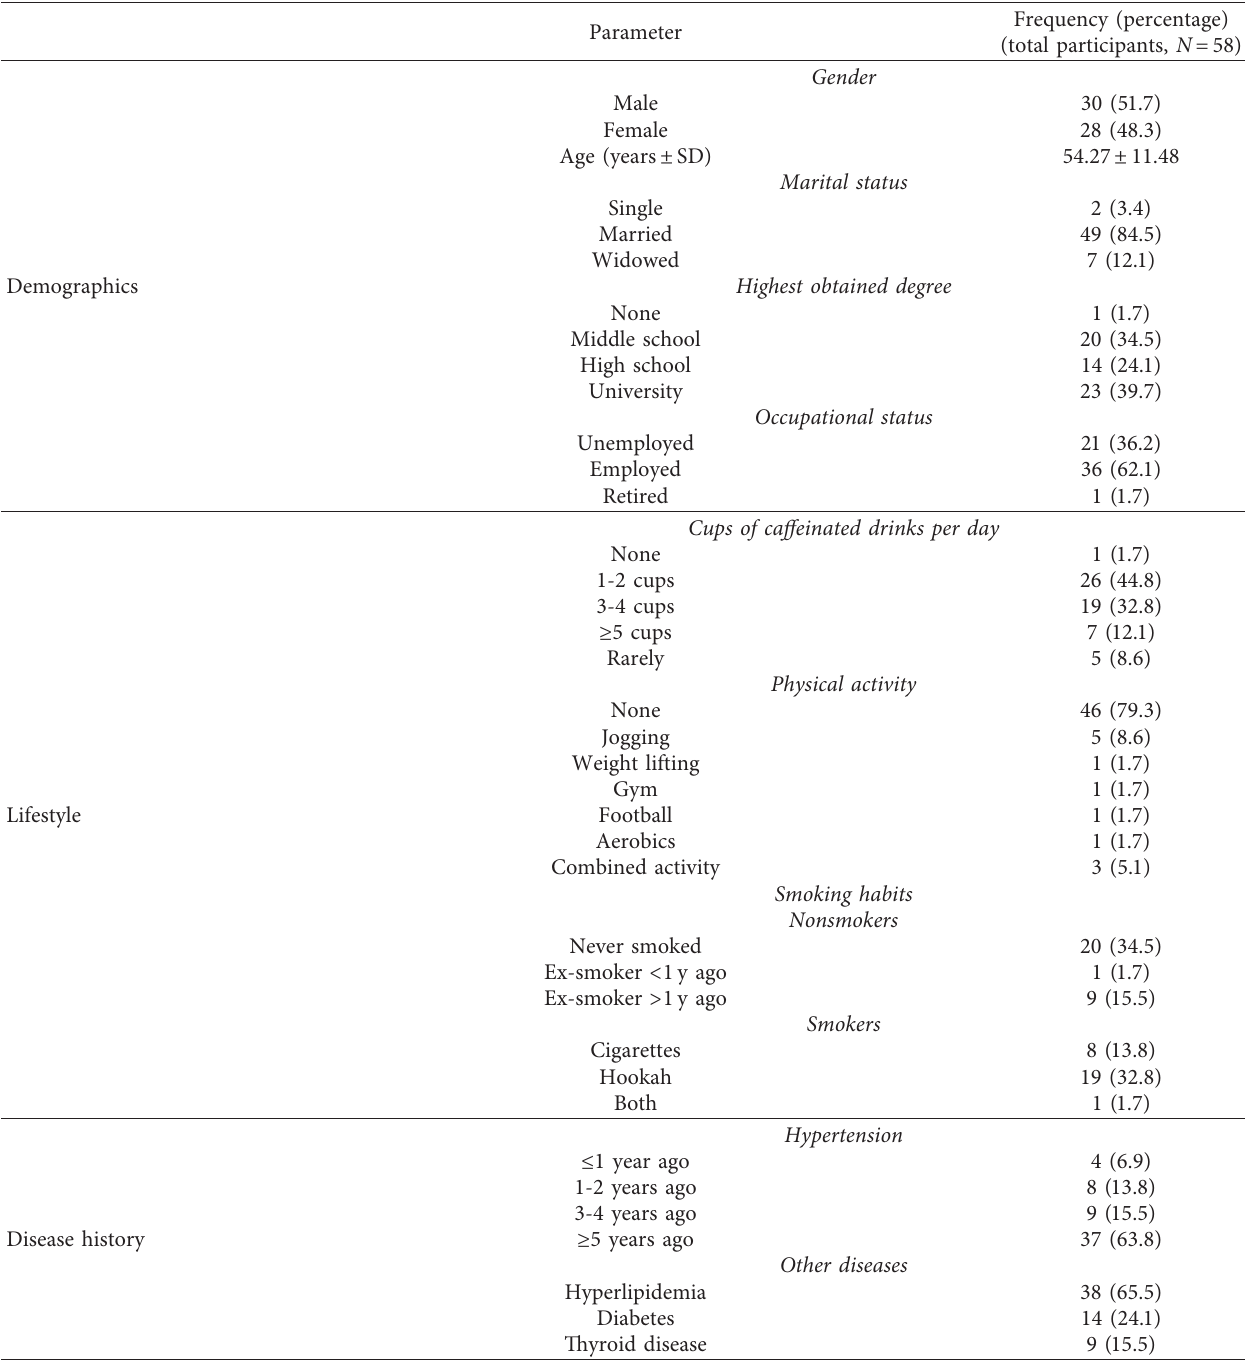
Table 1: Characteristics of included participants in terms of demographics, lifestyle, and disease